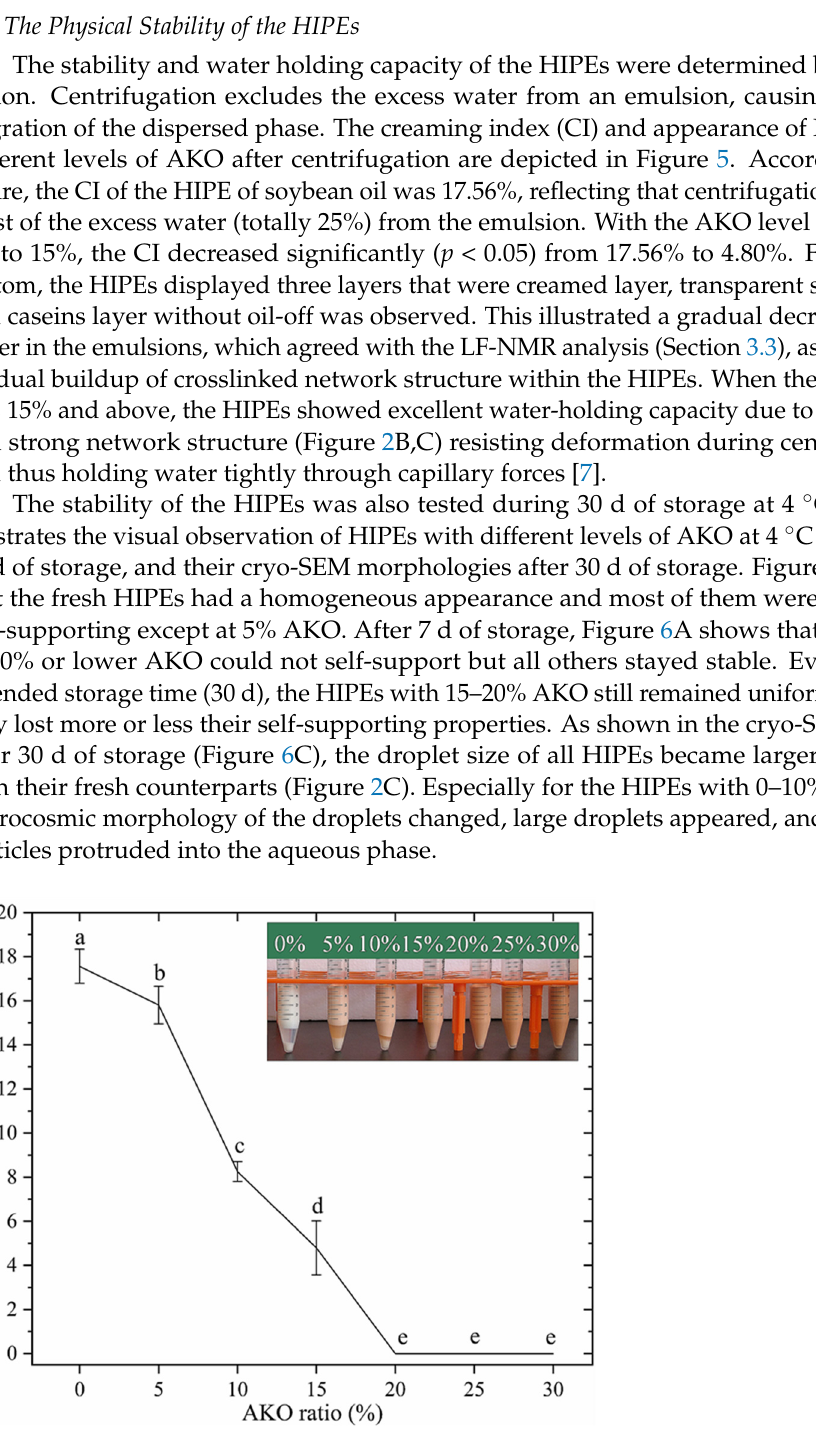
Figure 5. The creaming index (CI) and appearance (insert, after centrifugation) of HIPEs with different levels of Antarctic krill oil (AKO) (0, 5, 10, 15, 20, 25, and 30%, w/w ). Values with different letters (a–e) are significantly different ( p < 0.05).